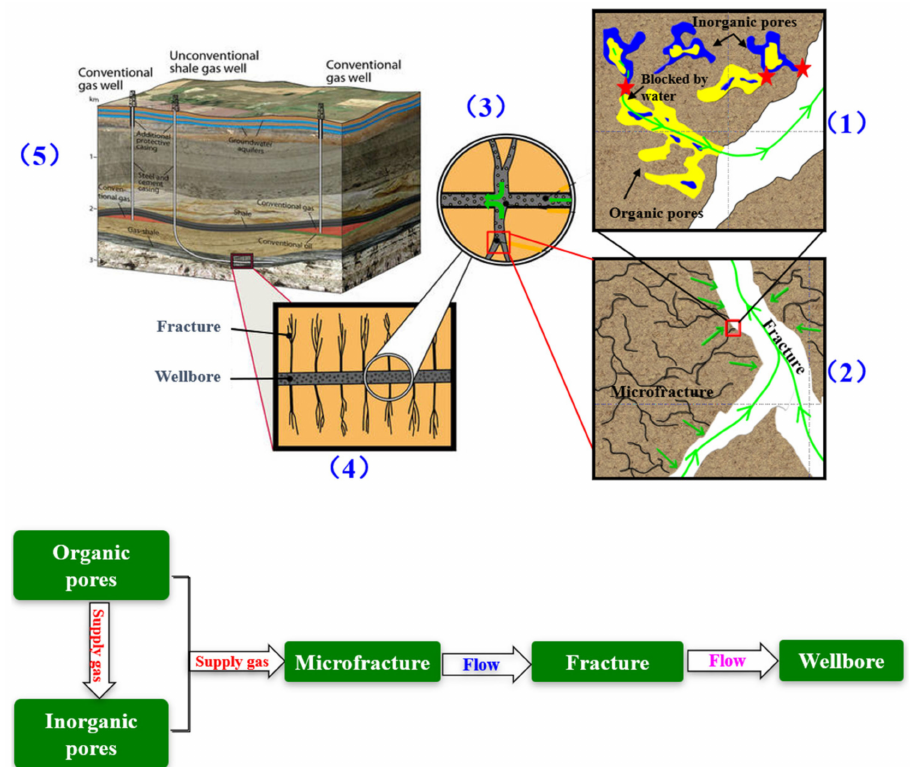
Figure 17. In order to model these coupled gas flow pathways, specialized software, such as Petrol and Eclipse by Schlumberger, is needed to build the reservoir models and conduct the reservoir simulations.